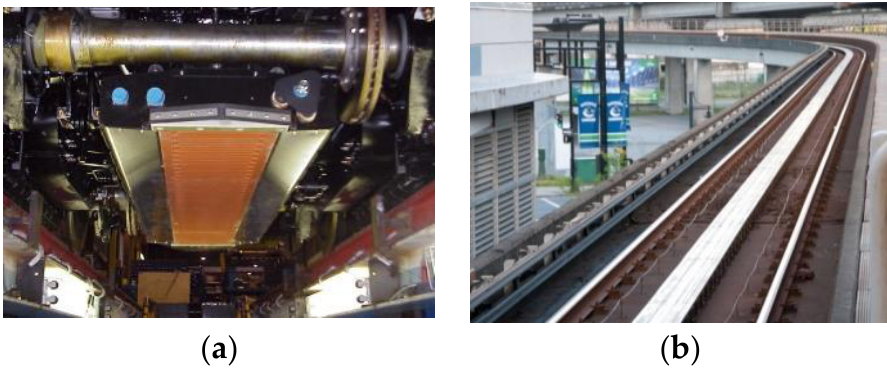
Figure 3. LIM primary (supplied part) ( a ); LIM secondary (reaction rail) ( b ) [28].